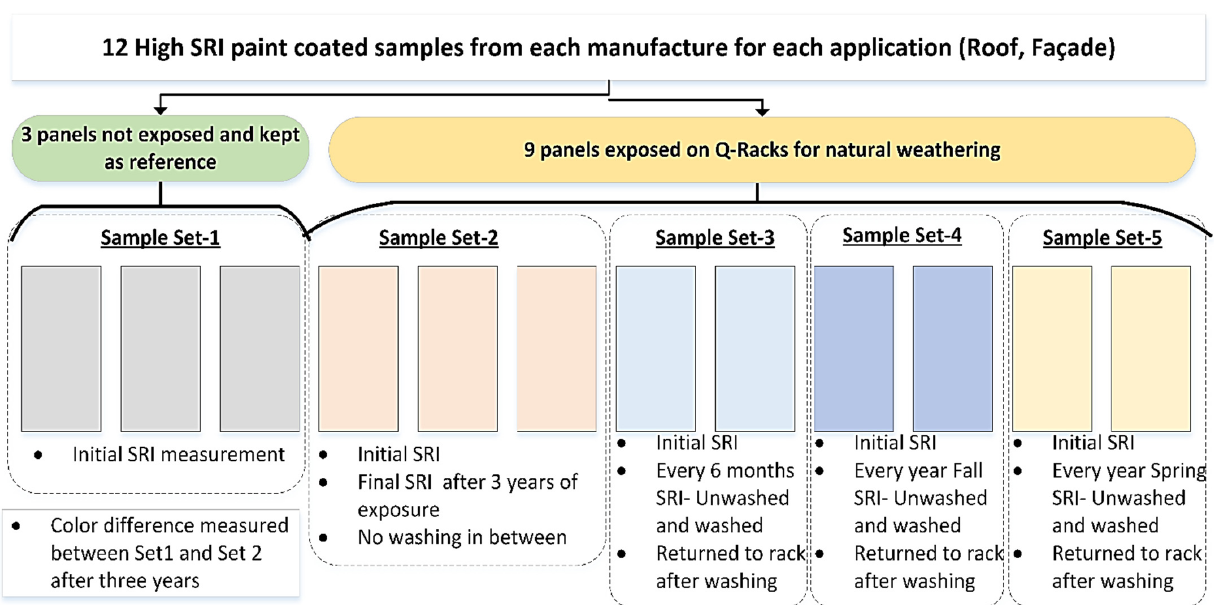
Figure 2. Flowchart representing the experimental methodology and parameter evaluation.